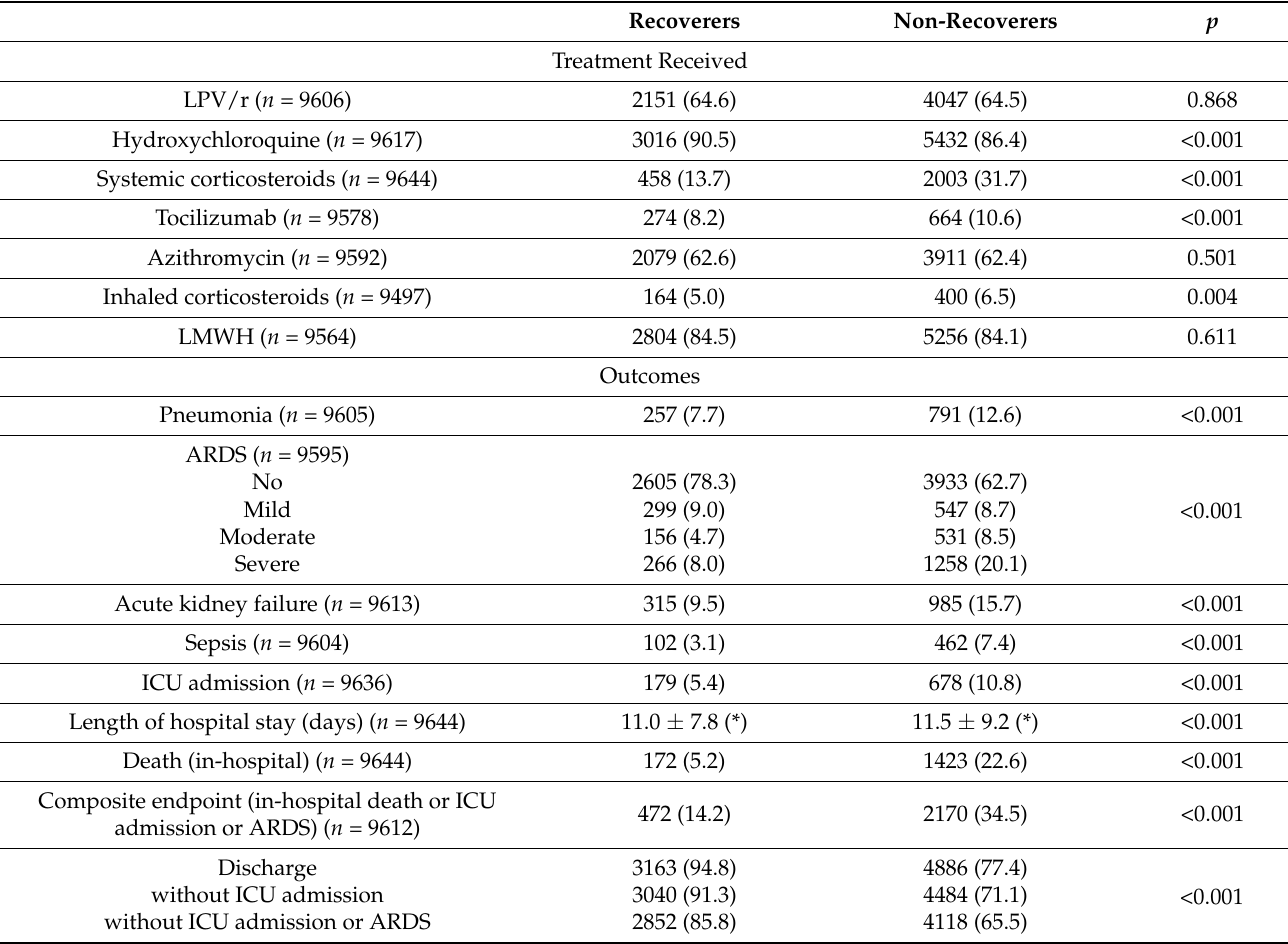
Table 2. Management and progress during hospitalisation of patients with and without eosinophil elevation. Recoverers Non-Recoverers p Treatment